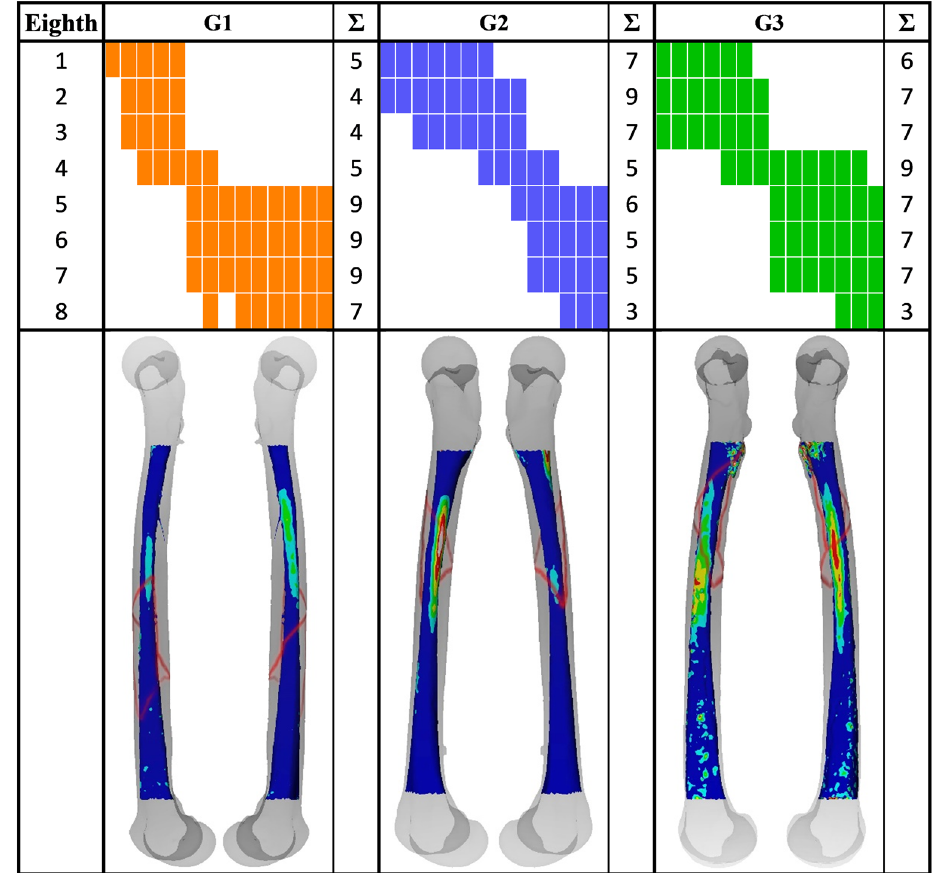
Table 3. Visualization and quantification of the fracture lines extent over the eighths in each of the three study groups G1, G2 and G3. Each column represents one femur. In the bottom row, representative pictures of one specimen per group, with relative decrease in femoral shaft wall thickness post reaming (color-coded) and fracture (red lines) are